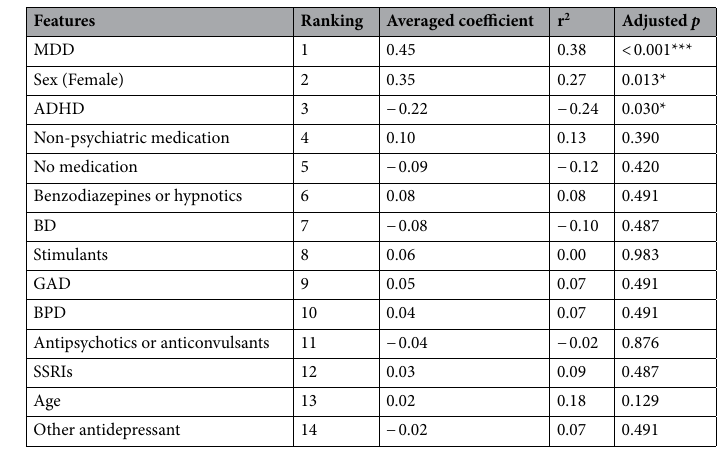
Table 2. Feature rankings. *** p < 0.001, * p < 0.05. p values were adjusted using Benjamini & Yekutieli’s method to control for multiple comparison 36